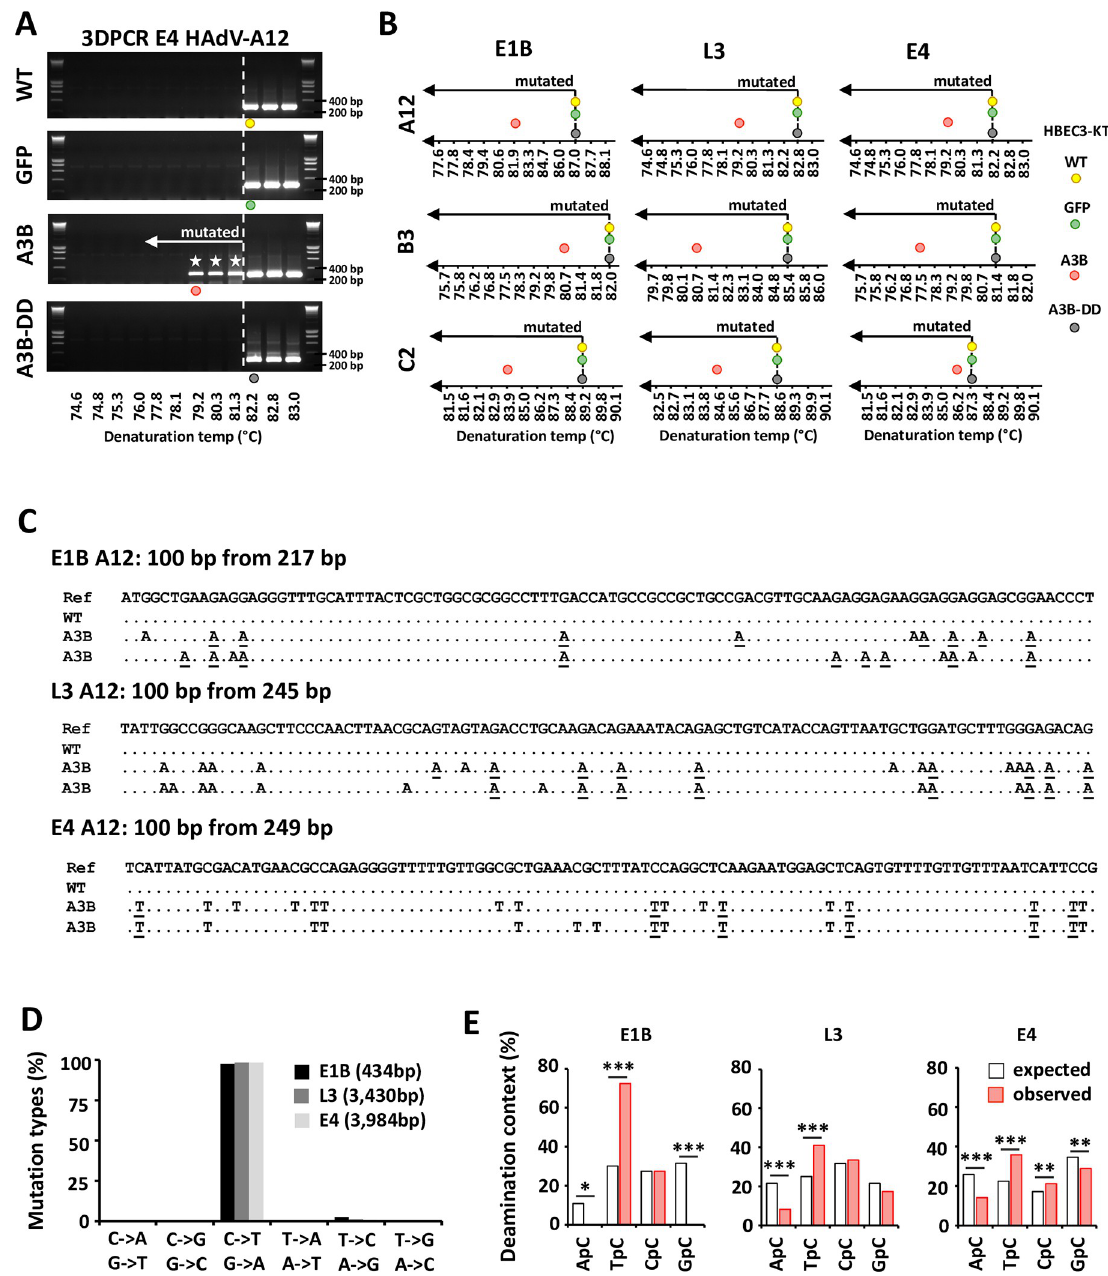
Fig 4. A3B introduces strand-coordinated C to T clustered mutations in the adenovirus genomes. HBEC-WT, -GFP, -A3B and -A3B-DD were infected with HAdV-A12, -B3 or -C2 and the intracellular DNA was extracted 48 hours post infection. 3DPCR reactions were conducted on the E1B, L3 and E4 genes. (A) Agarose gels illustrating 3DPCR reactions specific for the E4 gene of the A12 strain are shown. The dotted white line indicates the threshold between mutated and unmutated 3DPCR products. Low denaturation temperature amplicons were recovered in HBEC-A3B cells only. (B) Graphical representation of the 3DPCR results obtained for the 3 viral genes (E1B, L3 and E4), for the 3 viral strains (A12, B3 and C2) and for the 4 cell lines (WT, GFP, A3B and A3B-DD). The lowest denaturation temperatures allowing the production of the expected amplicons were represented on the gradients by colored circles. (C) 3DPCR products generated from HAdV-A12-infected WT and A3B-expressing cells were cloned and sequenced. Hypermutated sequences detected in A3B-expressing cells (A3B) were aligned against the reference viral genome (Ref) and against sequences isolated from WT infected cells (WT). Deamination occurred on the coding (C to T mutations) or the template strand (G to A mutations of the coding strand). The mutations underlined took place within an A3-favored motif with a T in 5’ of the deaminated C. (D) Mutation types recorded on the E1B, L3 and E4 hypermutated sequences. The numbers in brackets indicate the number of bases sequenced. (E) 5’ nucleotide contexts of the deaminated Cs recorded on the E1B, L3 and E4 hypermutated sequences were reported by red bars. 5’ nucleotide context